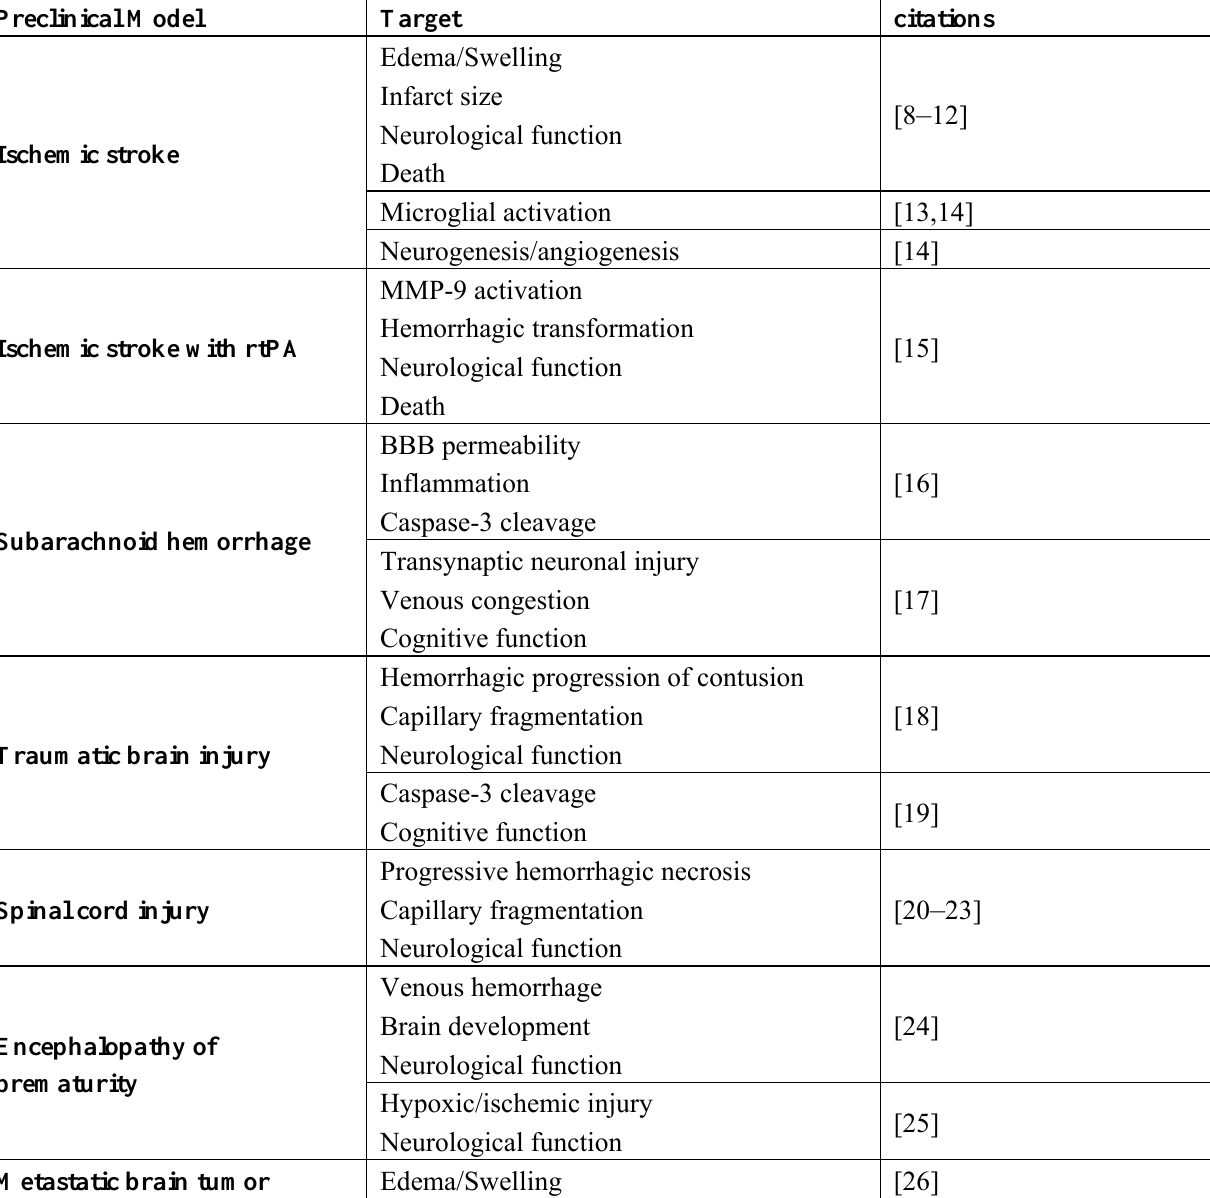
Table 1. Targets of